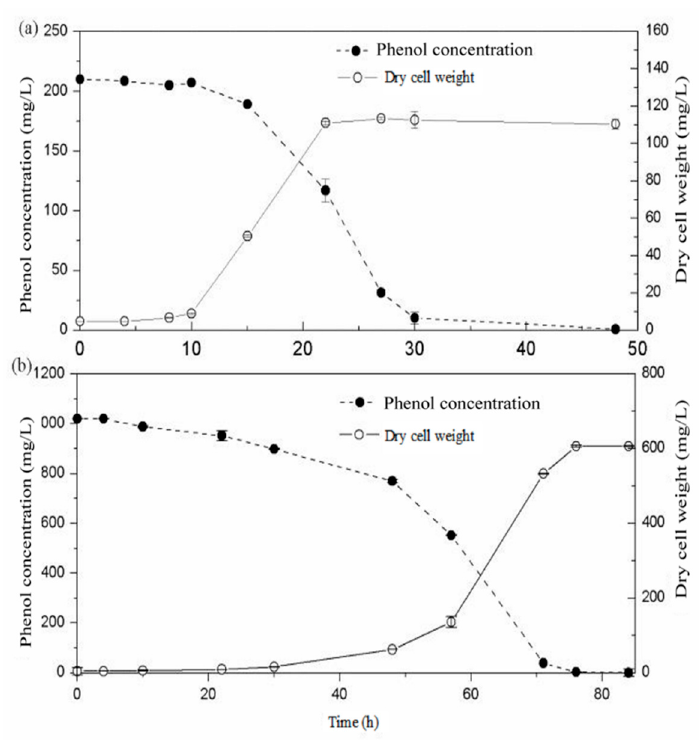
Figure 1. Degradation of phenol by Rhodococcus sp. SKC at initial concentrations of ( a ) 210.0 and ( b ) 1019.0 mg/L. Dry cell weight (DCW, mg/L) = 320.0 × OD 600 .